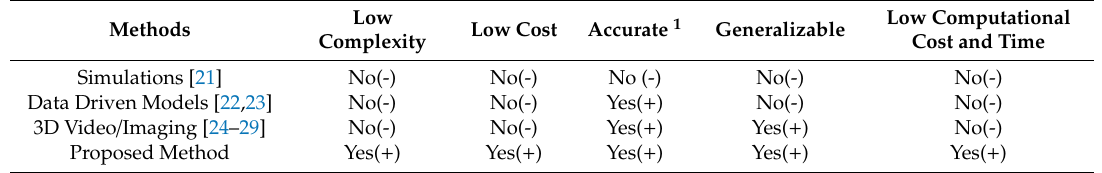
Table 1. Comparison of state-of-the-art textile-modeling methods with respect to desirable parameters.